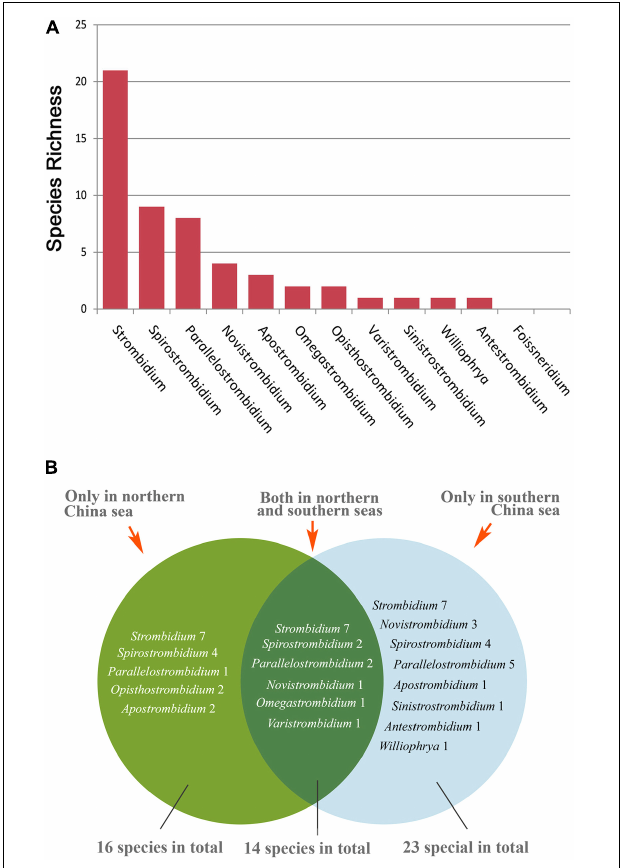
FIGURE 4 | Diversity of strombidiids collected from China (A) Species richness of each genus. (B) Comparison of species composition between coastal waters of northern and southern